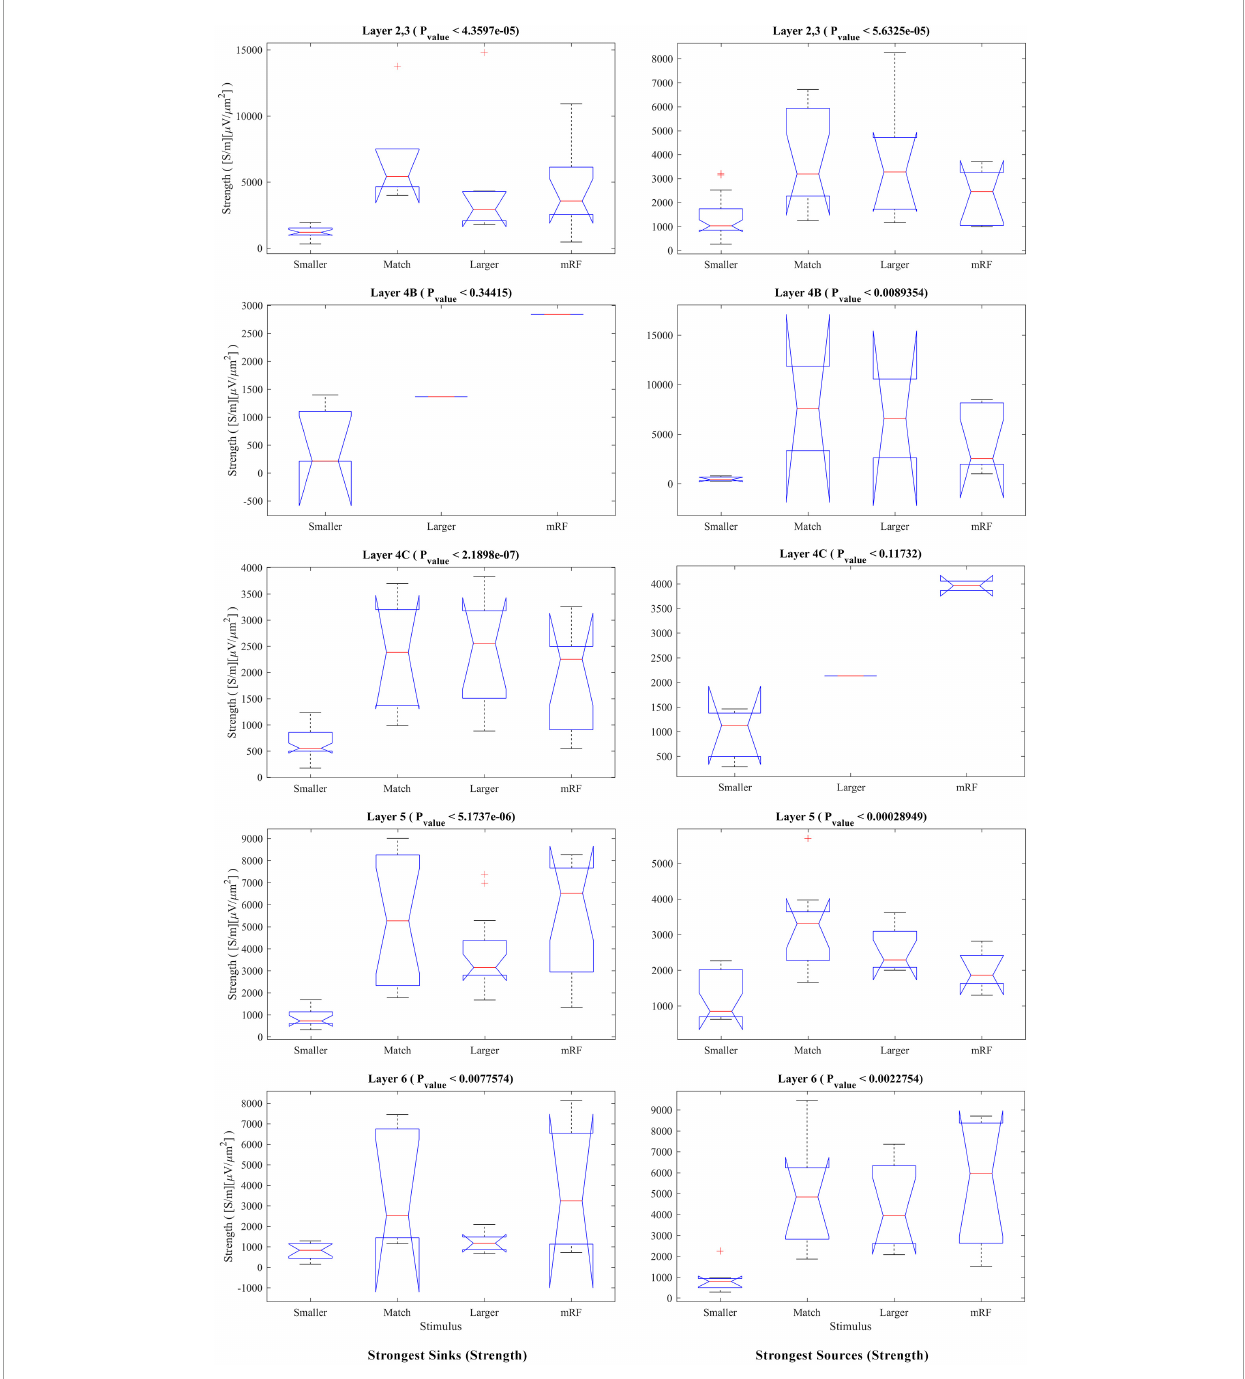
FIGURE9 The Kruskal–Wallis test for sink and source strengths based on the type of stimulus. The Kruskal–Wallis test in Figure 7 is shown in this figure with the approach of comparing stimulus types in each layer. The (left column) shows the strongest sinks and the (right column) shows the strongest sources. The Y-axis expresses the power of the sink or source. Other cases are similar to Figure 8